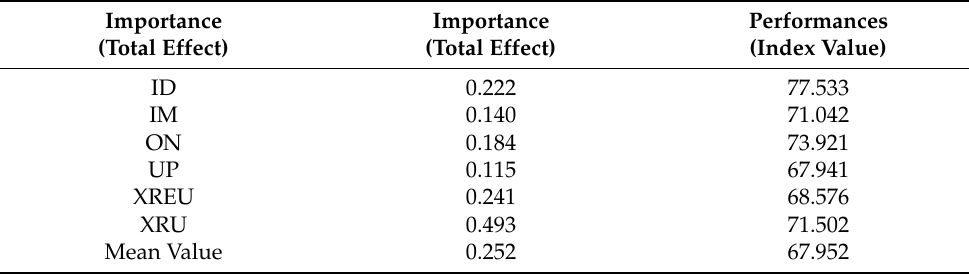
Table 11. Importance Performance Map Results.